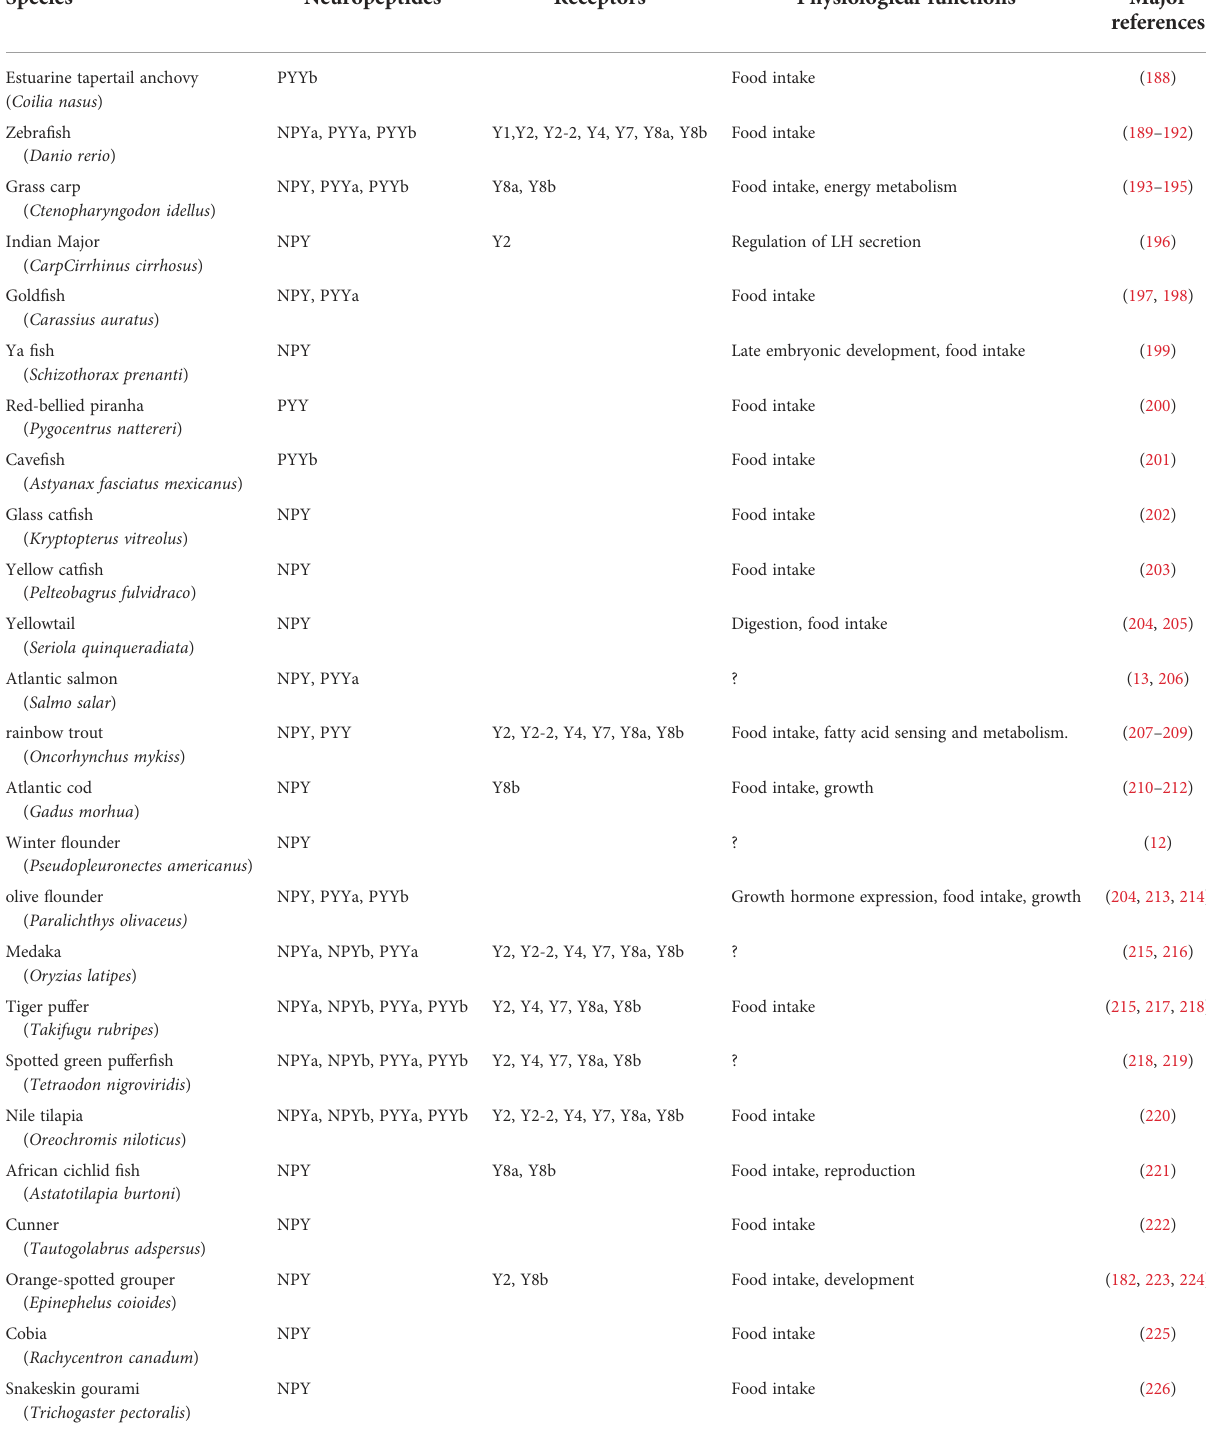
TABLE 3 Neuropeptide Y and its receptors on growth and food intake in fi